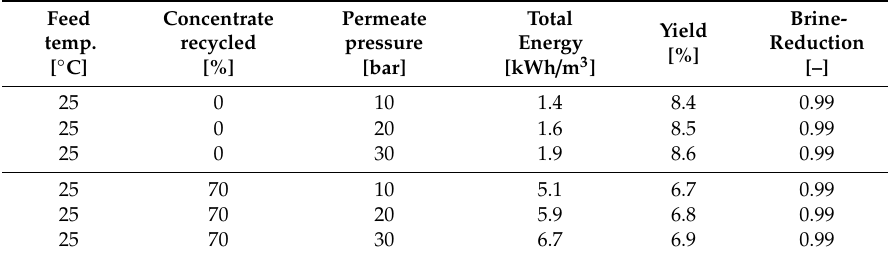
Table 8. Optimized results of SW30XHR-440i membrane at 25 ◦